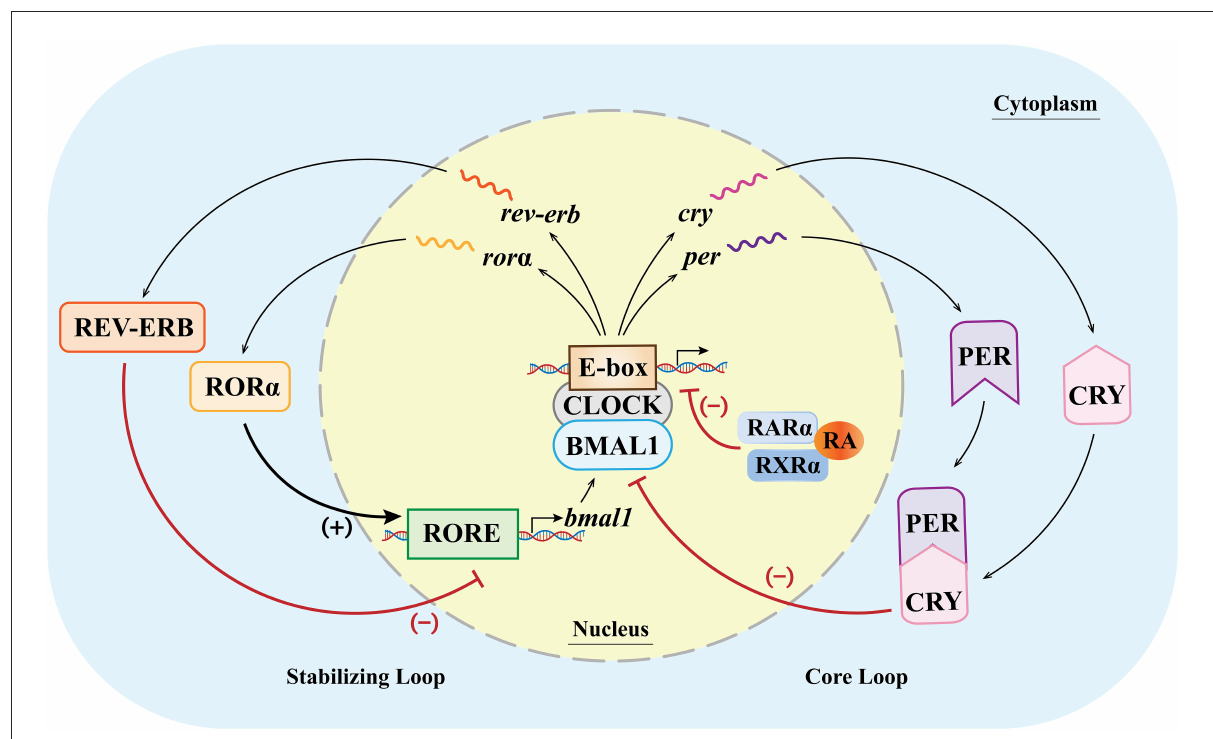
FIGURE2 Clock genes and their transcription–translational feedback loops (TTFLs) at the cellular level (inside/outside the nucleus) in mammals. In the core loop, CLOCK and BMAL1 dimers bind to the E-box, promoting the expression of the Per and Cry genes and, in turn, inhibiting the CLOCK/BMAL1-dimer-dependent gene expression. In the stabilizing loop, the combination of the CLOCK/BMAL1 dimer and the E-box can activate the expression of ROR α and REV-ERB. The accumulation of the REV-ERB molecule can inhibit the expression of the BMAL1 gene, while the accumulated ROR α molecule can activate the expression of the BMAL1 gene (lower case italic characters and single wavy lines indicate mRNA). ( + )/ → means activating gene expression; (–)/T means inhibiting gene